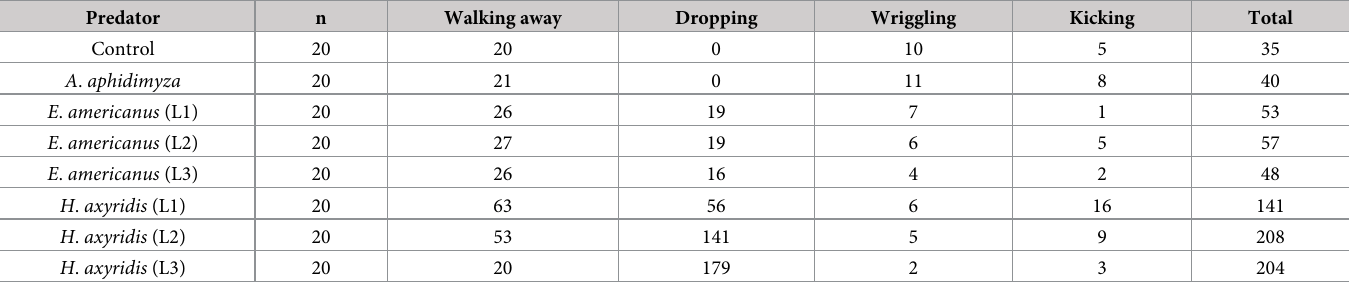
Table 1. Cumulative total number of the different aphid defensive acts elicited by the different predators.